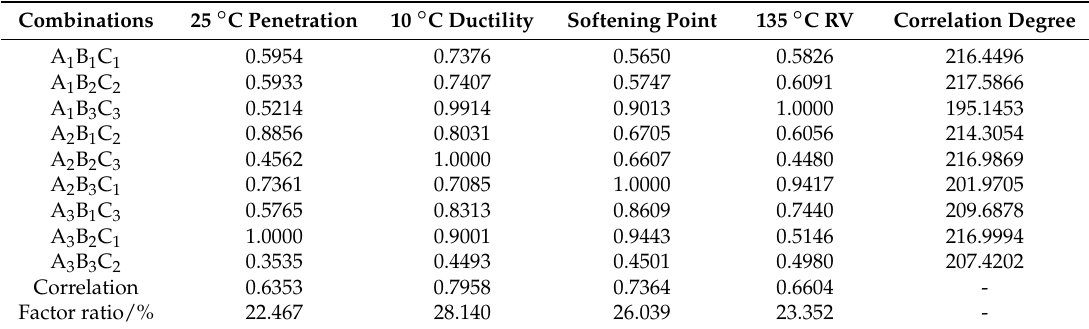
Table 6. GCA Analysis Results.